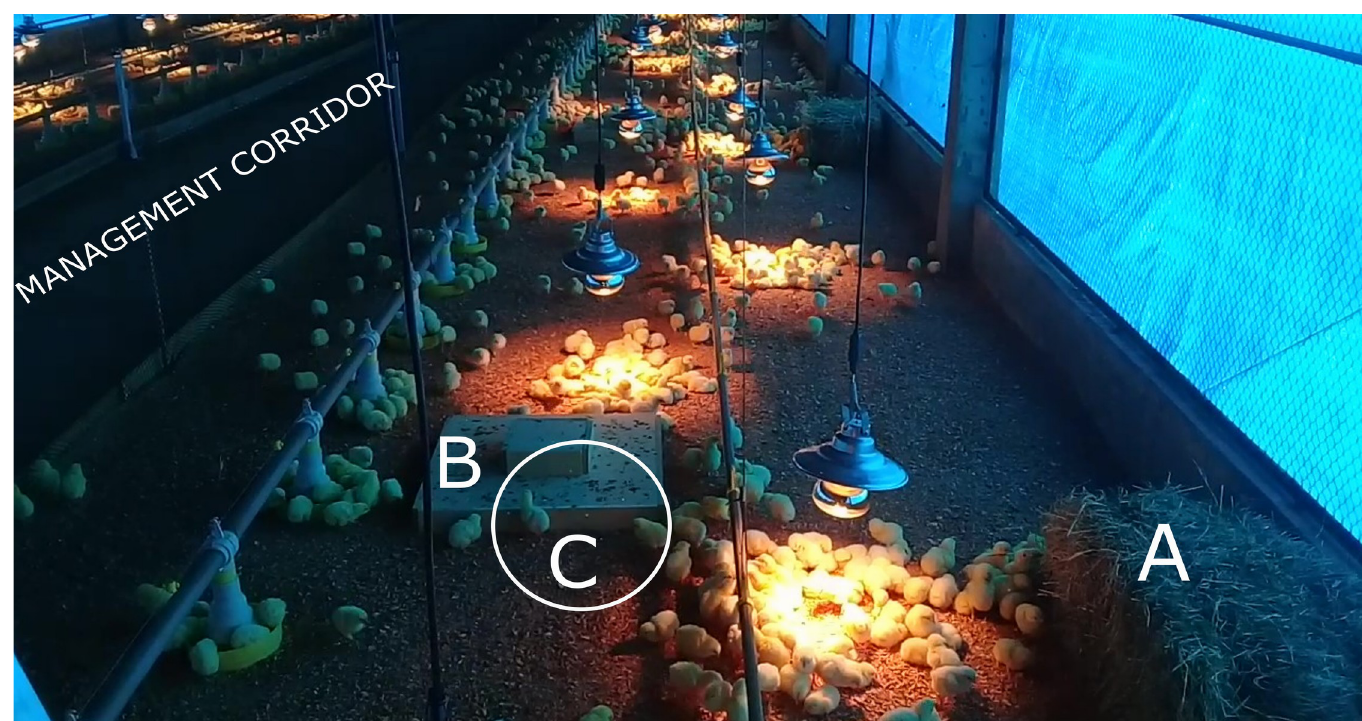
Fig 1. Birds housed in the environment containing environmental enrichment (EE). (A): Step platform, (B): Straw bale, (C): Laser spots.